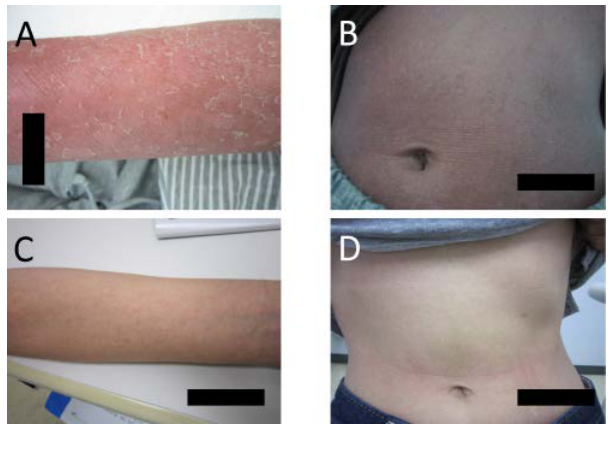
Figure 2. Skin feature. At relapse, the patient suffered from ery- throderma. At complete remission, the erythroderma disap- peared. A) The skin of antebrachium at relapse after transplanta- tion. B) The skin of abdomen at relapse after transplantation. C) The skin of antebrachium at complete remission after discontin- uation of immunosuppressants. D) The skin of abdomen at com- plete remission after discontinuation of